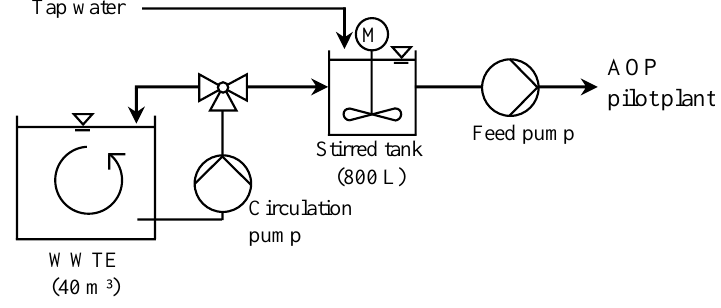
Figure 4. Scheme of the process setup in UV/chlorine AOP Exp. B with different WWTE dilutions.